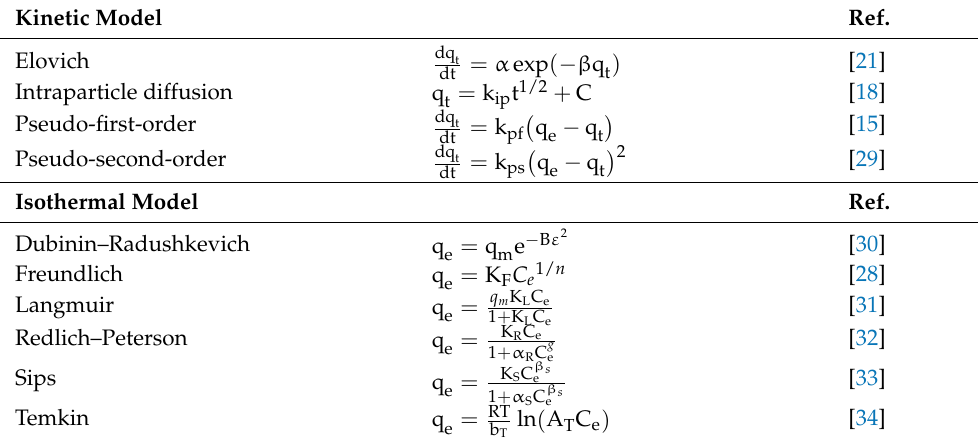
Table 1. Summary of the adsorption isotherms and kinetic